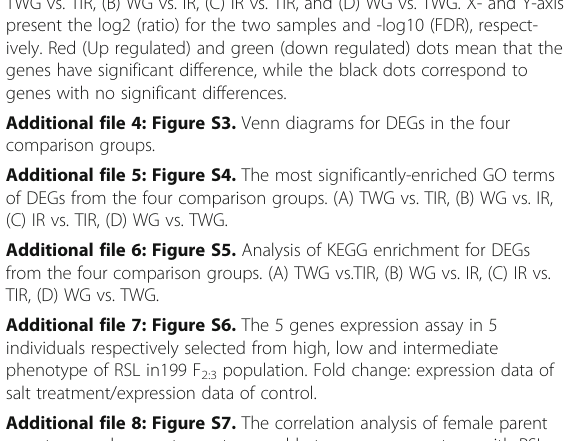
Additional file 1: Figure S1. Box-plot of phenotypic statistical of SNK in two pools. SNK: Na + /K + ratio of shoots. Additional file 2: Table S1. An overview of the QTL-seq results. Table S2. SNPs results between two parents and two mixed pools. Table S3. Annotated genes within the interval detected by QTL-seq. Table S4. Phenotypic variation of parents and F2:3 lines. Table S5. Summary of Illu- mina transcriptome reads mapped to the reference genome. Table S6. Statistics of transcriptome sequencing results. Table S7. RNA-seq data of the genes in candidate region. Table S8. The KASP genotyping results. Table S9. ANOVA results of three genotypes. Table S10. The Arabidop- sis homologous genes of Os07g0569700. Table S11. The genotype of 1 bp Indel in 66 diverse rice accessions. Table S12. Primers of 25 KASP markers. Table S13. The KASP reaction system. Table S14. Primers for qRT-PCR in this study. Additional file 3: Figure S2. Volcano plots for expressed genes in the four comparison groups. Volcano plots for all the expressed genes in (A) TWG vs. TIR, (B) WG vs. IR, (C) IR vs. TIR, and (D) WG vs. TWG. X- and Y-axis present the log2 (ratio) for the two samples and -log10 (FDR), respect- ively. Red (Up regulated) and green (down regulated) dots mean that the genes have significant difference, while the black dots correspond to genes with no significant differences. Additional file 4: Figure S3. Venn diagrams for DEGs in the four comparison groups. Additional file 5: Figure S4. The most significantly-enriched GO terms of DEGs from the four comparison groups. (A) TWG vs. TIR, (B) WG vs. IR, (C) IR vs. TIR, (D) WG vs. TWG. Additional file 6: Figure S5. Analysis of KEGG enrichment for DEGs from the four comparison groups. (A) TWG vs.TIR, (B) WG vs. IR, (C) IR vs. TIR, (D) WG vs. TWG. Additional file 7: Figure S6. The 5 genes expression assay in 5 individuals respectively selected from high, low and intermediate phenotype of RSL in199 F 2:3 population. Fold change: expression data of salt treatment/expression data of control. Additional file 8: Figure S7. The correlation analysis of female parent genotype, male parent genotype and heterozygous genotype with RSL. Abbreviations BSA: Bulked segregant analysis; QTL: Quantitative trait locus; RIL: Recombinant inbred line; ED: Euclidean distance; DEGs: Differentially expressed genes; InDel: Insertion deletion; KASP: Kompetitive allele-specific PCR; qRT-PCR: Real time quantitative polymerase chain reaction; SNPs: Single nucleotide polymorphisms; GO: Gene ontology; KEGG: Kyoto Encyclopedia of Genes and Genomes; PVE: Phenotypic variation explanation; S-pool: